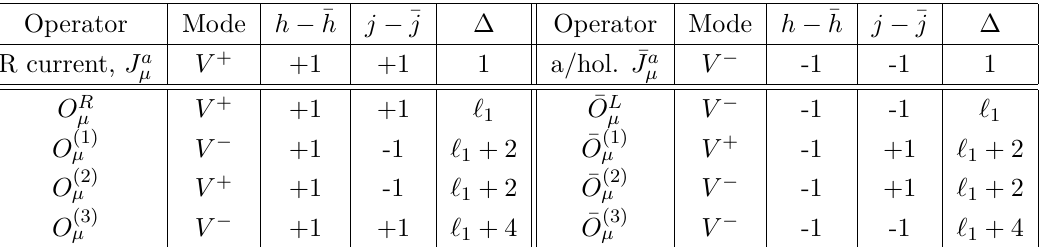
Table 1 . Operators described by the vector perturbations R µa and C µa . The first line corresponds to the special cases of the SU(2)